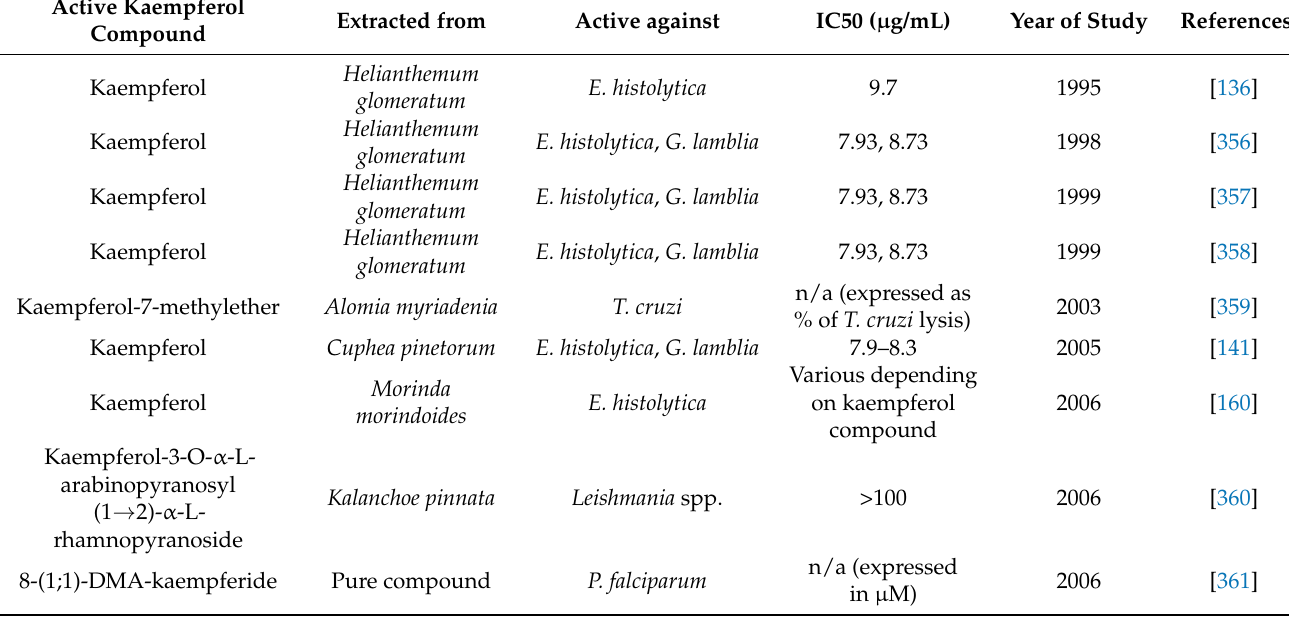
Table 6. Antiprotozoal activity of kaempferol compounds based on current